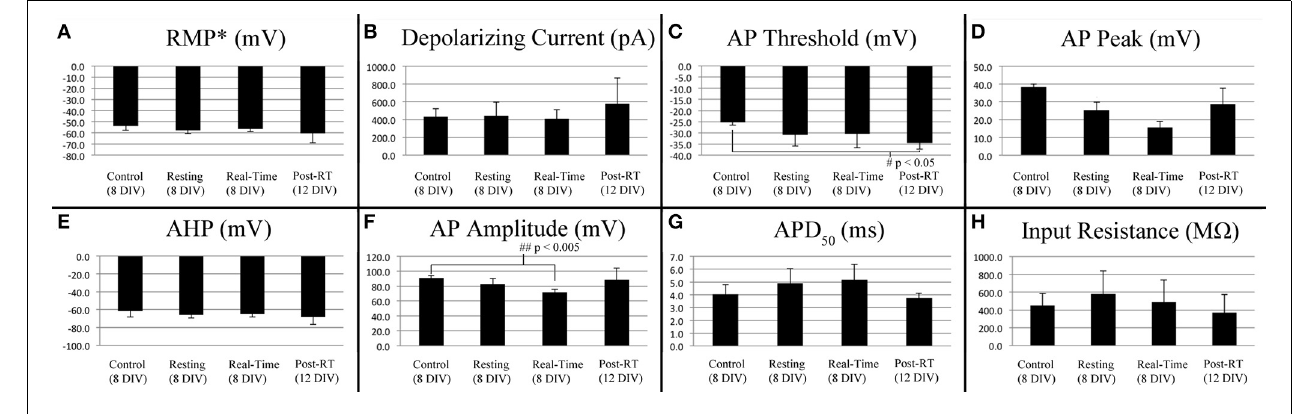
FIGURE 6 | Current stimulated action potential attributes. Data represents averages attained from non-stretched controls (8DIV, n = 4 ), stretch-grown cells at rest following initial stretch-growth (Resting, 8DIV, n = 3 ), stretch grown cells during real-time stretch (Real-Time, 8DIV, n = 3 ), and cells at rest 3–4 days following real-time stretch (Post-RT,